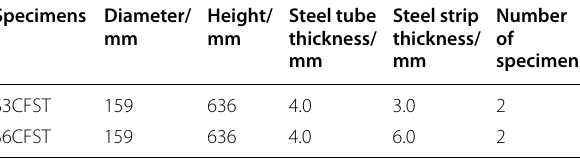
Table 2 Welded steel strip-strengthened CFST